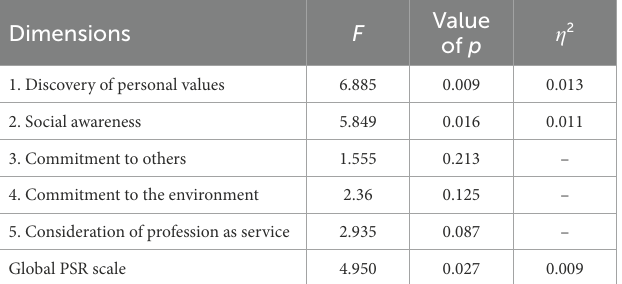
TABLE 8 Descriptive analysis of the group of women according to university